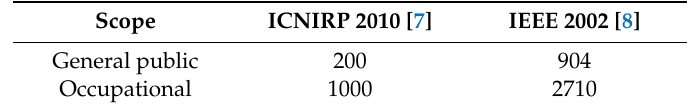
Table 1. Reference values for both general public and occupational exposure ( µ T) at 50/60 Hz.